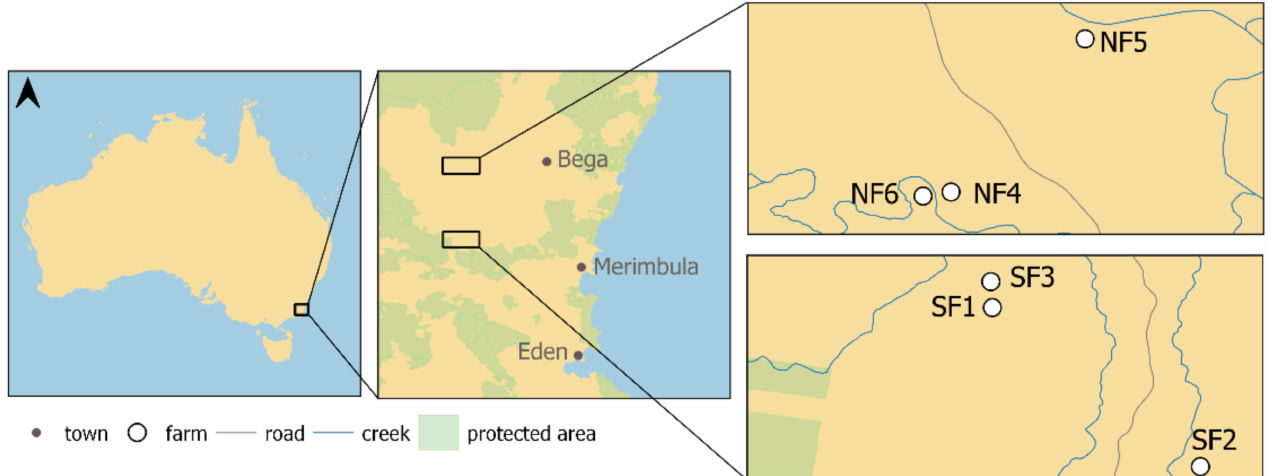
Figure 5. Map outlining the region of study including the location of farms with the experimental set-up. On each farm are two sites, one of them with a high ALG cover and the other dominated by native grasses (mainly KG). N = North, S = South, F = farm. The map was created and adapted from Open Street Map (OSM; provided by Geofabrik [62]) and the World Database of Protected Areas